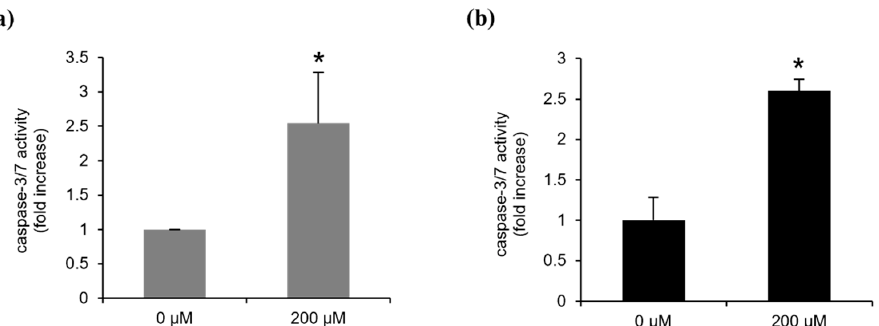
Figure 5. Continentalic acid inhibits caspase 3/7 activity. Caspase-3/7 activity was monitored using ELISA-based bioluminescence assays after treatment with vehicle (0 μ M of continentalic acid; 1%